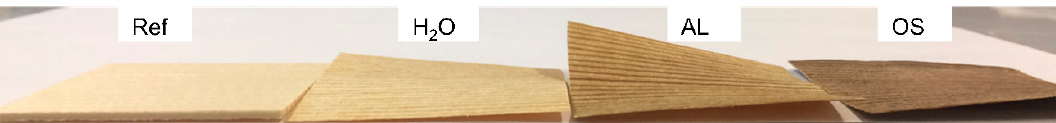
Figure 2. Representative photographs of single veneers in untreated condition (Ref), densified after soaking with water (H 2 O), densified after alkali-delignification (AL), and densified after organosolv delignification (OS).